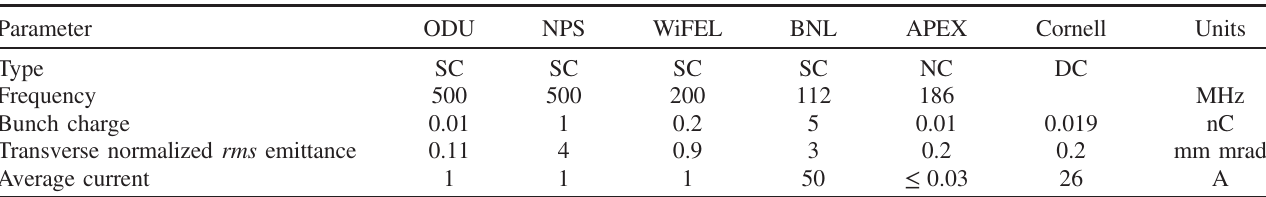
TABLE V. Comparison of various gun designs [15,43 – 45]. All superconducting guns are indicated by (SC) and have a reentrant geometry.